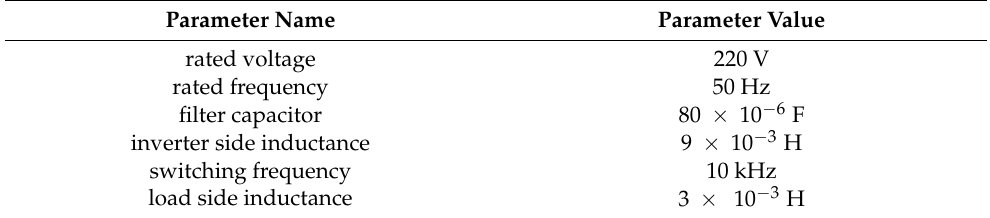
Table 1. Main circuit simulation parameters.